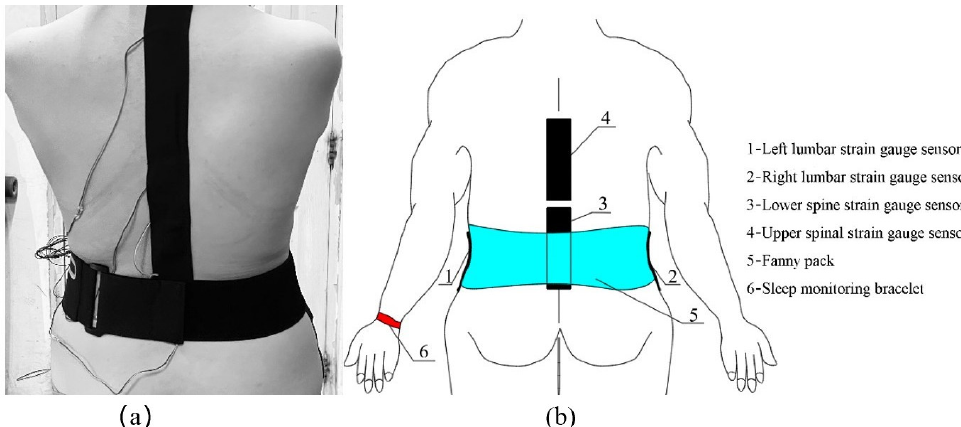
Figure 4. Diagram of the subject wearing the sensor: ( a ) the actual diagram of the subject wearing the sleeping-position monitoring device; ( b ) the schematic diagram of the subject wearing the sensor. When the subject’s sleeping position changes, the four flexible angle sensors bend; thus, the output voltage signal fluctuates as the sleeping position changes. The six-axis motion sensor in the waist pack changes the x -axis acceleration and angular velocity in response to the turning movement.